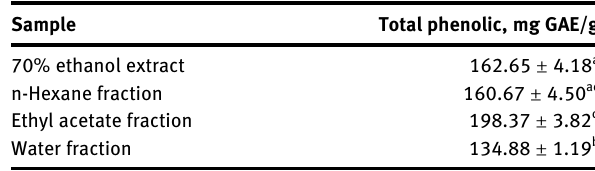
Table  : Total phenolic content of extract and fraction of P. crocatum